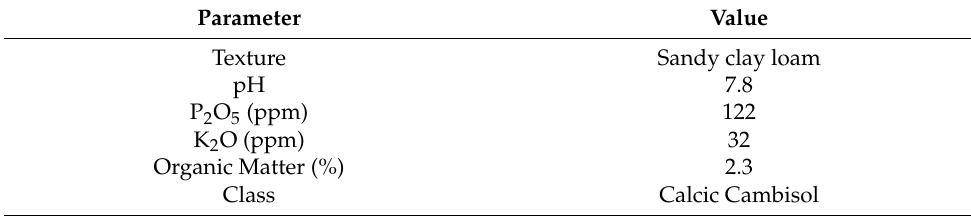
Table 2. Analytical soil characteristics of the experimental plots.